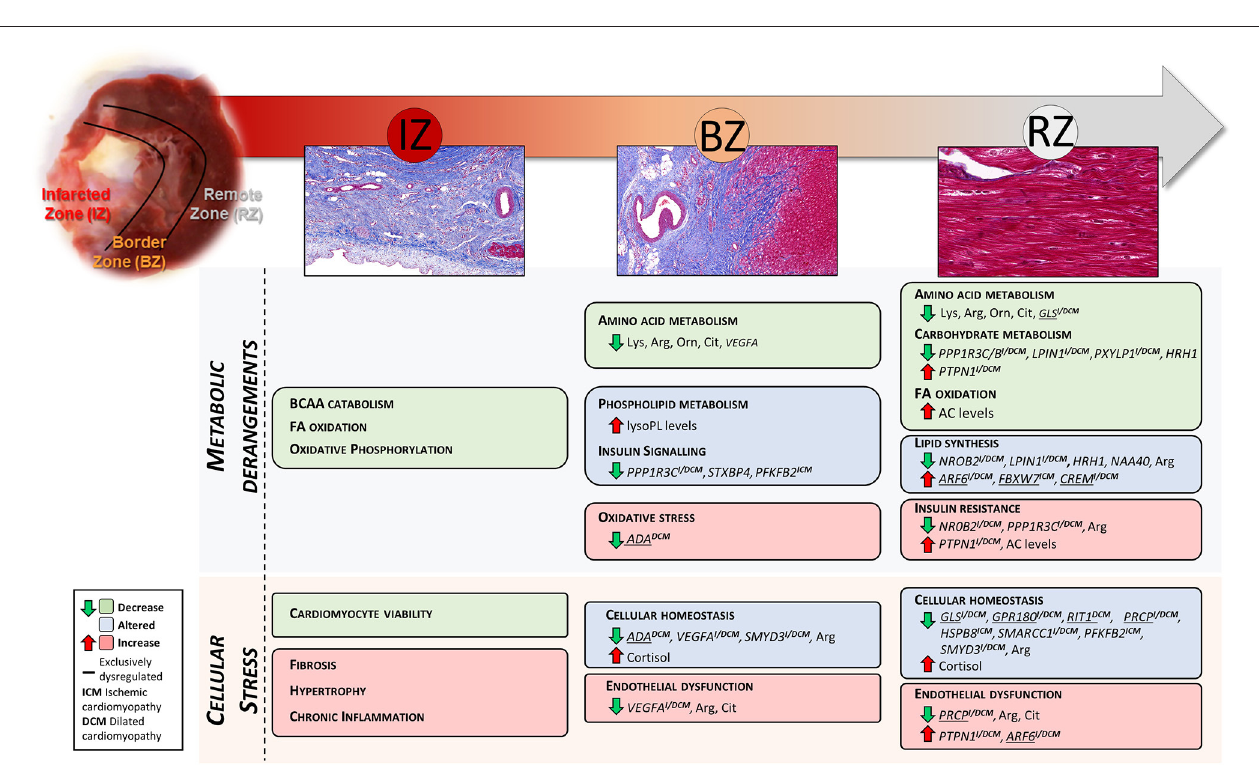
FIGURE 5 | Summary of the LV region-specific metabolic and cellular derangements found in this study. Underlined genes were found significantly dysregulated exclusively in the referred tissue zone. Genes demarked with ICM and DCM were also found significantly dysregulated in LV biopsies from ischemic and dilated cardiomyopathy patients,